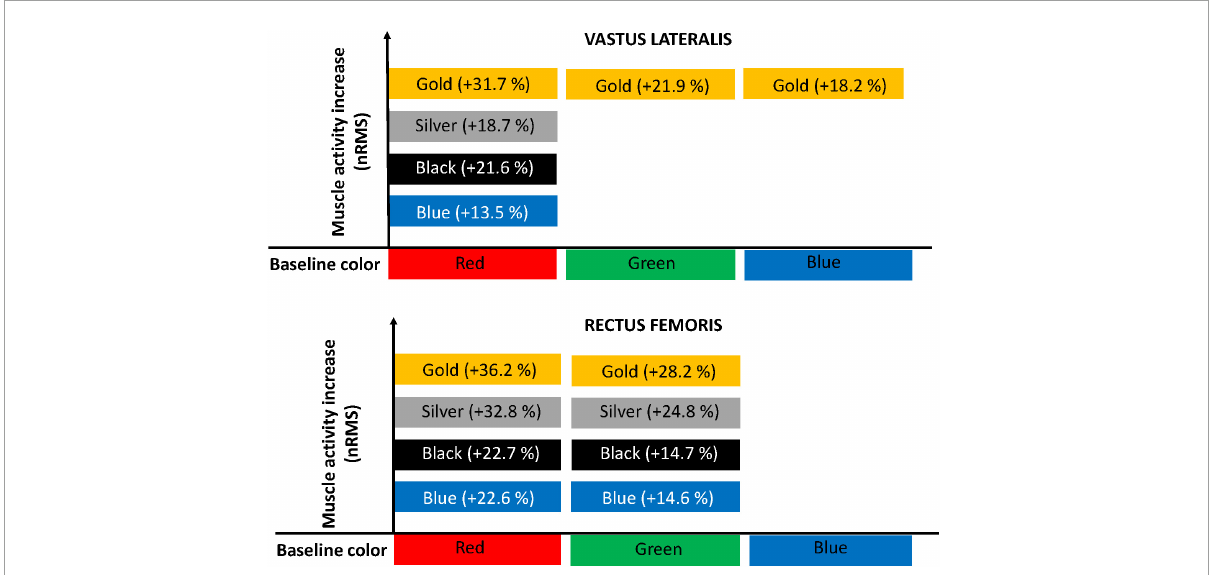
FIGURE3 Diagram representation of increment of muscle activity. For the vastus medialis muscle, there were no root-mean-square (nRMS) increases when the resistance level progressed.